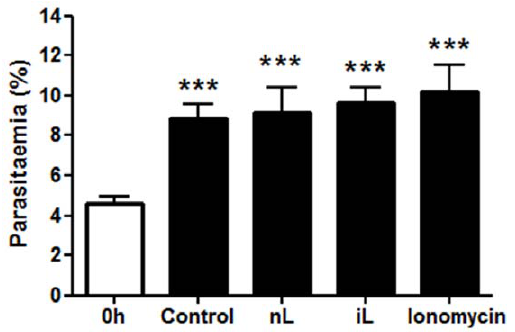
Figure 3. Effect of ionomycin in P.falciparum parasite growth. Asynchronous cultures (0 h) were maintained for 18 h in presence of ionomycin or lysates of non-treated (nL) or ionomycin-treated (iL) RBC and, then, parasite growth was evaluated in Giemsa-stained thin blood smears. Non-treated cultures were used as control. Data represent mean 6 S.D. of parasitaemia of the cultures performed in fiveplicate. *** indicates significant difference (p , 0.001; ANOVA) from initial culture (0